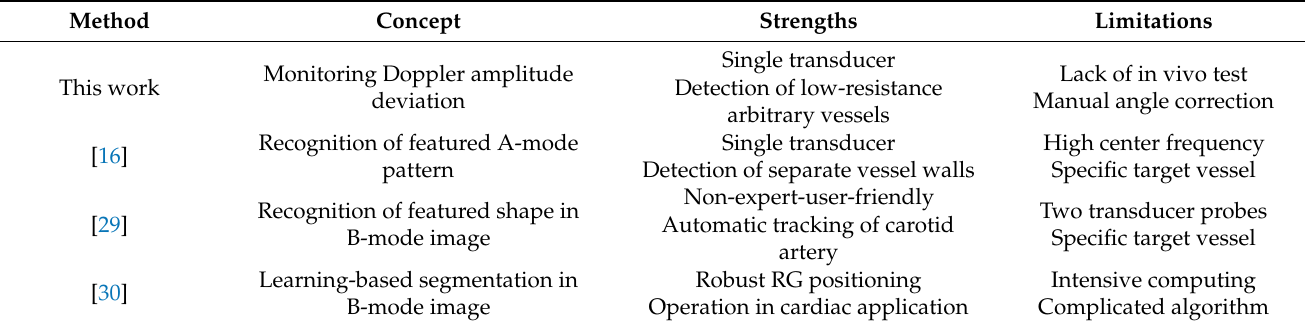
Figure 20. ( a ) Measured supply voltage of water pump to arbitrarily adjust the fluid velocity, ( b ) acquired Doppler sample volume, and ( c ) reconstructed spectrogram. Table 2. Comparison of automatic vessel detection